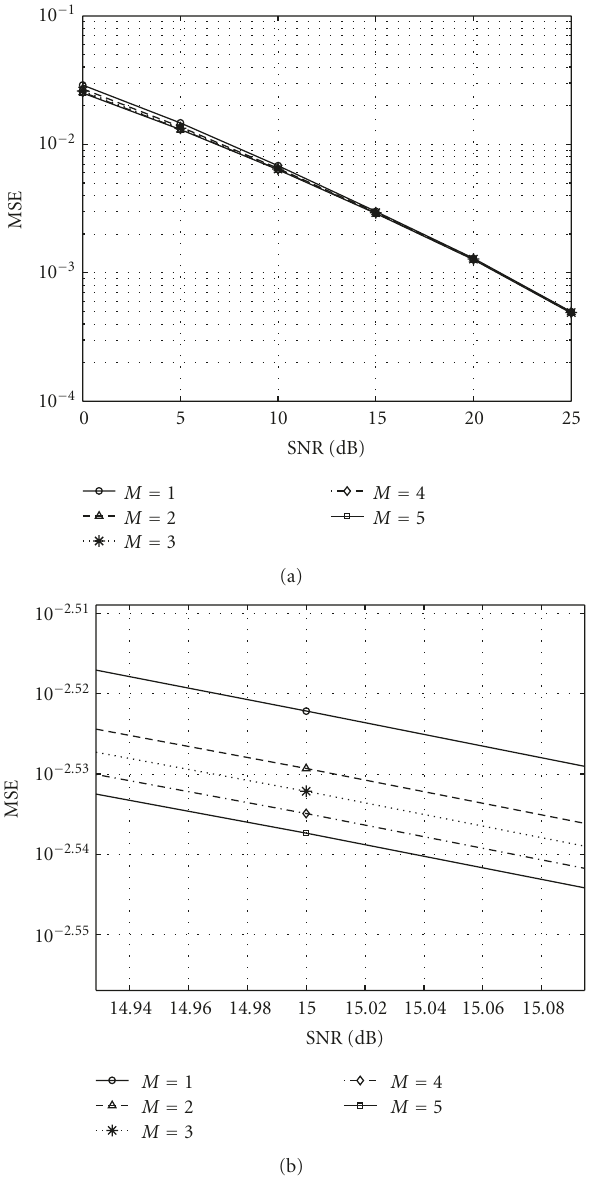
Figure 8: Performances for di ff erent memory length. (a) Large- scale view, (b) zoomed-in